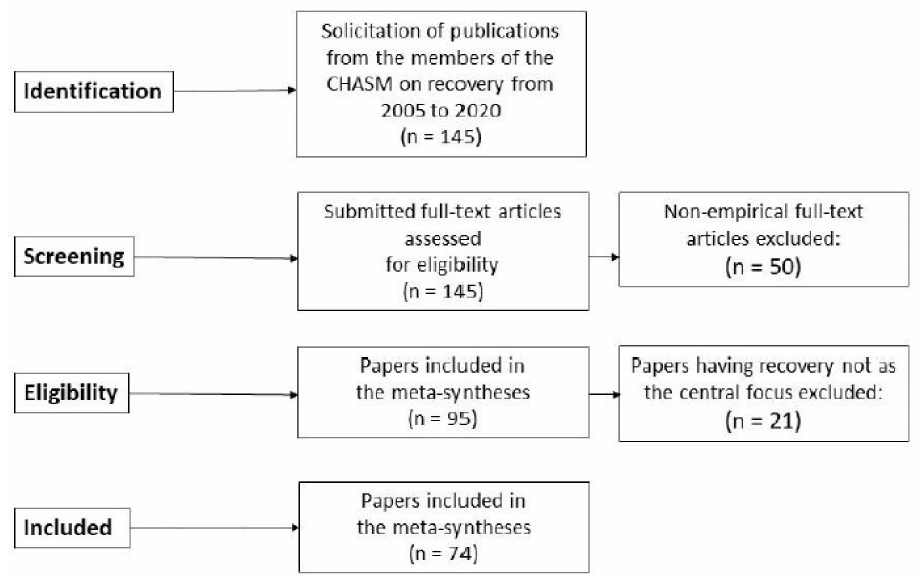
Figure 1. Flow chart of the process of gathering the publications for the